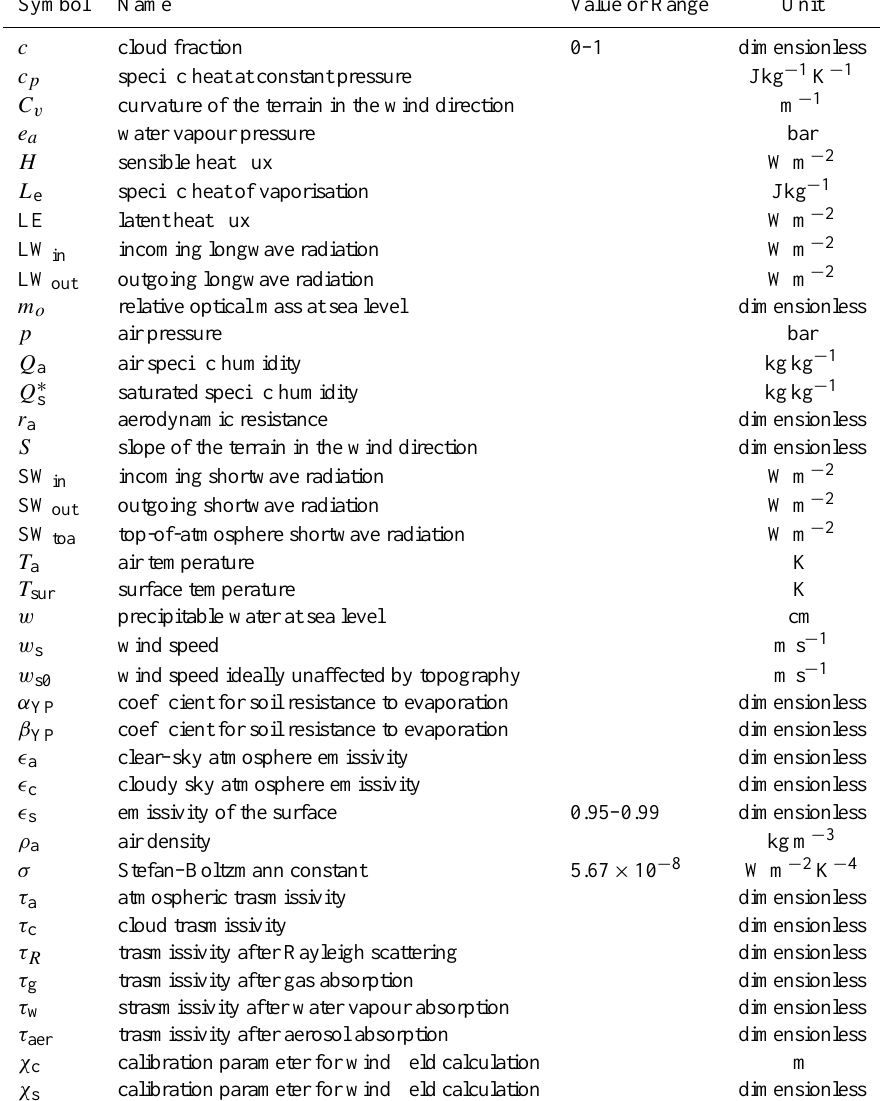
Table D4. Table of symbols for the atmospheric variables.